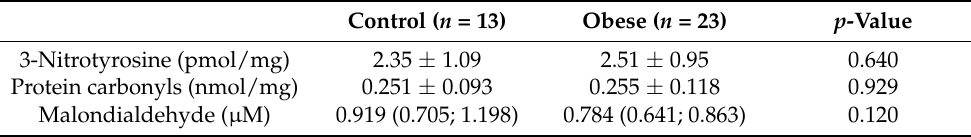
Table 3. Plasma biomarkers of oxidative stress by study group.